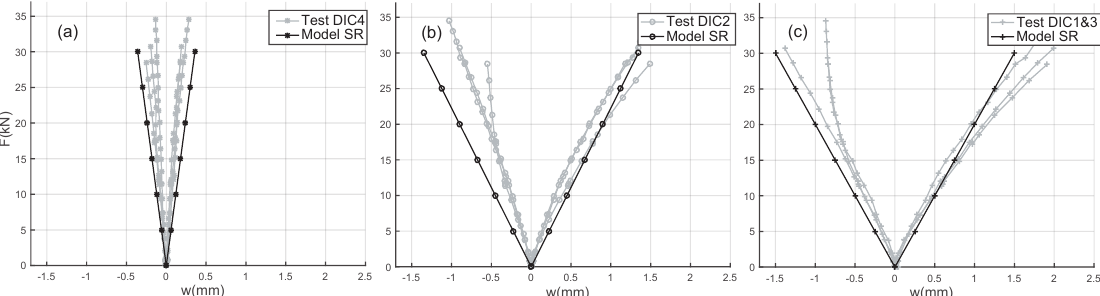
Figure 8. Displacement comparison between the tests and SR model caused by flange